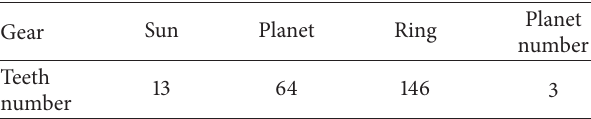
Table 1: Gear parameters of single stage planetary